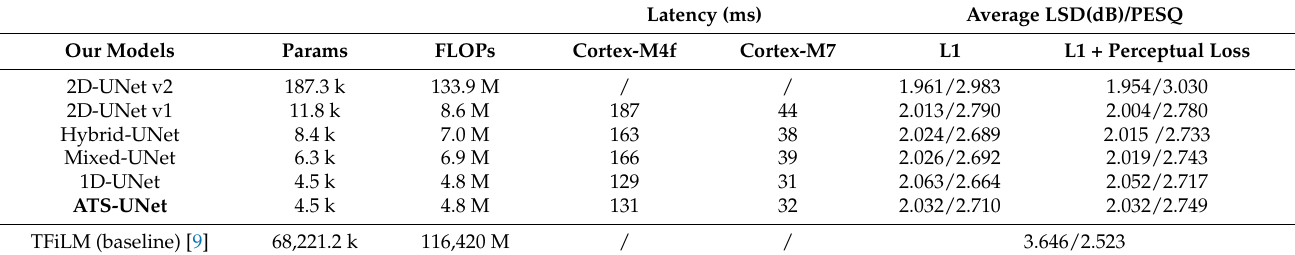
Table 2. Performance comparison for different UNet architectures. Latency is the model inference time on a single 2048-point frame by Arm Cortex-M4f/M7 processor. For 2D-UNet v2 and TFiLM, latency was not provided as they are too large to be deployed on our embedded system. Latency (ms) Average